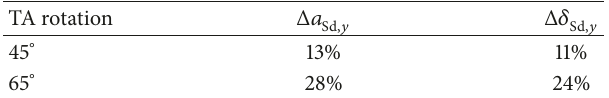
Table 13: Percentages of response reduction for two proposed orientations.